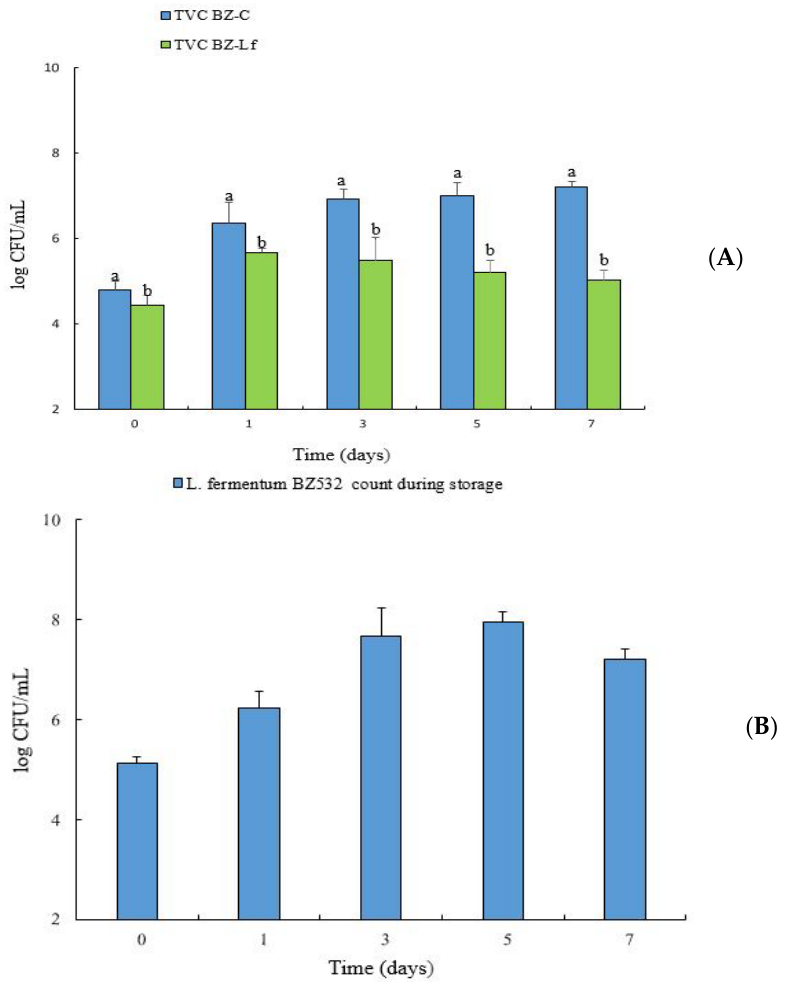
Figure 2. Changes in ( A ) TVC of bozai treatments and ( B ) LAB enumeration during storage of 7 days at 4 °C. Data with different letters represent significant differences ( p < 0.05)